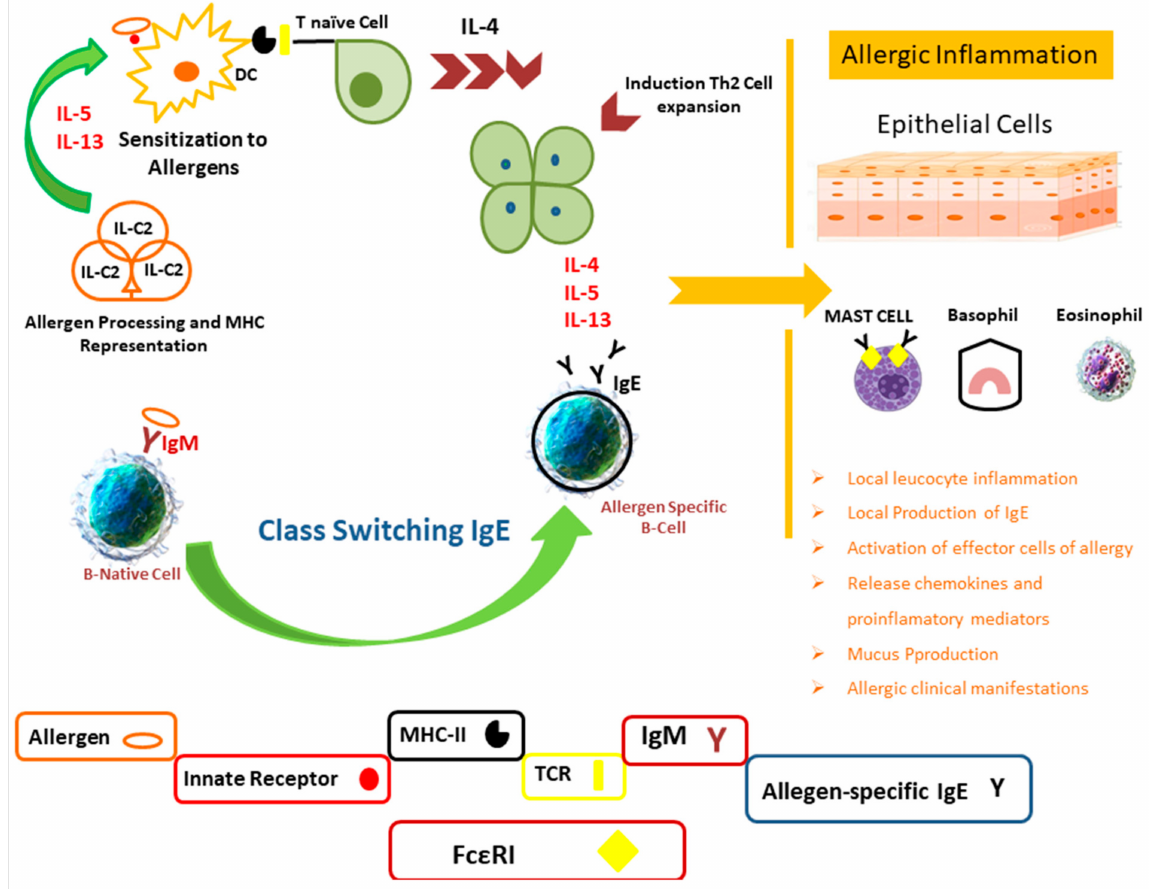
Figure 2. Allergic reaction